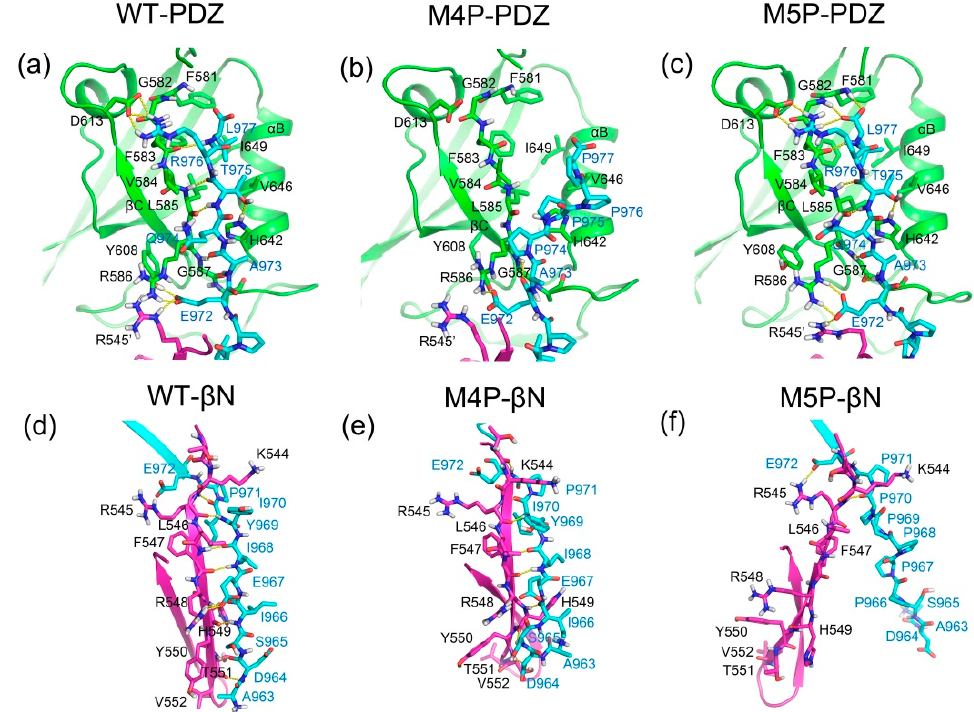
Figure 8. Representative binding modes from the MD simulation of WT, M4P and M4P systems. The binding of E-PBM in PDZ binding pocket are shown in ( a ) (WT, 47.36 ns), ( b ) (M4P, 66.84 ns) and ( c ) (M5P, 63.32 ns). The binding of E-PBM with β N1 ′ are shown in ( d ) (WT, 47.36 ns), ( e ) (M4P, 66.84 ns) and ( f ) (M5P, 63.32 ns). PDZ domain, β N1 ′ and E-PBM are colored in green, magenta and cyan, separately. Key residues are shown in stick model. Hydrogen bonds are shown in yellow dash lines.